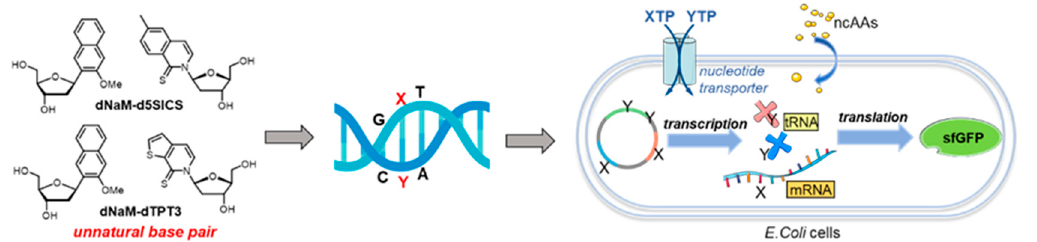
Figure 11. Construction of semi-synthetic organisms with